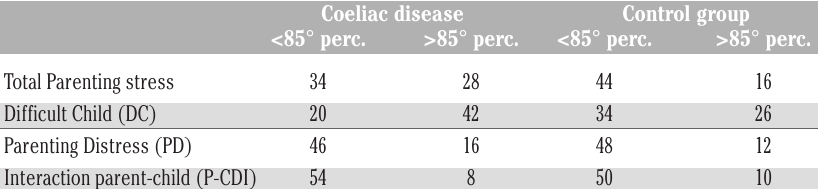
Table 3. Descriptive analysis about PSI-SF and its subscales scores reported by parents with celiac disease children (N=62) and parents of control group (N=60) Coeliac disease Control group <85°